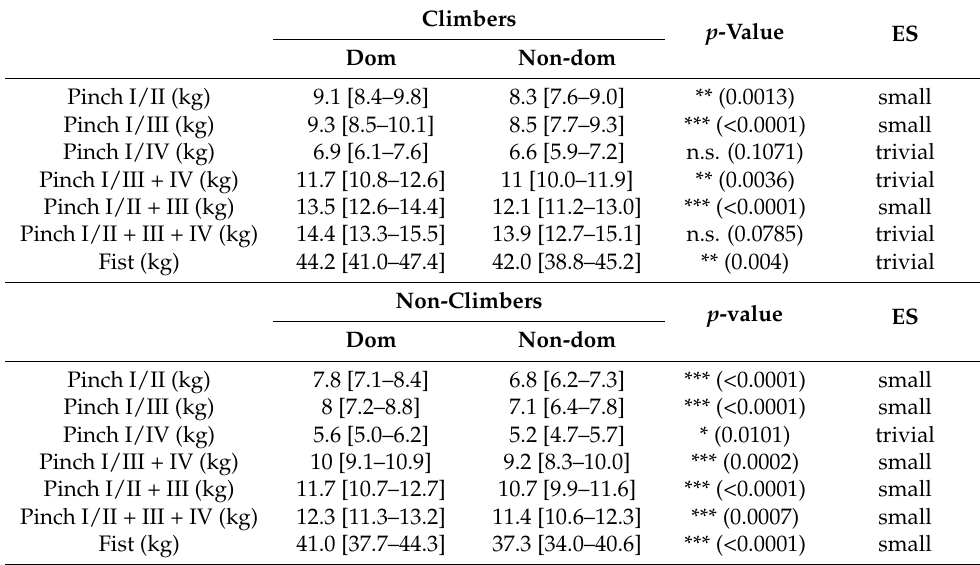
Table 3. Pinch force characteristics between the dominant (Dom) and non-dominant (Non-dom) hand among climbers and non-climbers. Differences are expressed between the right and left hand (paired t-test) and effect size is reported